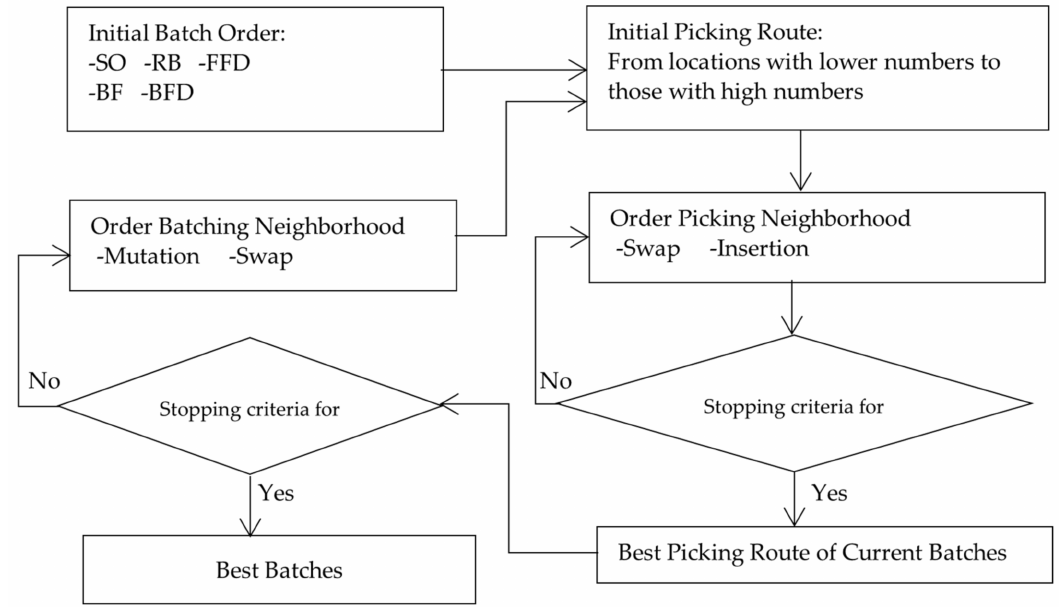
Figure 3. The framework of the proposed